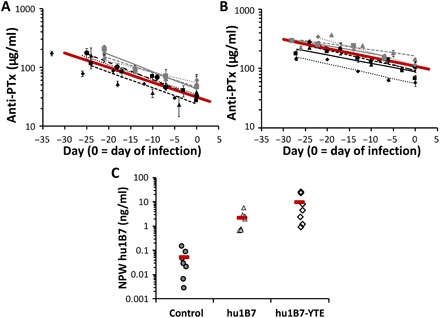
Extended half-life antibody hu1B7-YTE persists longer than hu1B7 in neonatal baboons.Serum antibody concentrations were determined by PTx ELISA and fit to determine the β-decay rate and serum half-life of (A) hu1B7 and (B) hu1B7-YTE before infection. Data for each treated animal are shown with a unique symbol and line fit with the average decay for each antibody shown in a bold red line. The two datasets are significantly different (P < 0.01) on the basis of the two-tailed t test assuming unequal variances with α = 0.05. (C) Hu1B7 was detected in the nasopharyngeal wash (NPW) samples of animals 2 to 4 days after infection, which corresponds to 29 to 42 days after antibody infusion. Each group mean is shown as a red bar (n = 7 per group). Data for all animals are shown except for hu1B7-treated animal T2, which was excluded from this analysis on the basis of the Grubb’s test for outliers with α = 0.05.